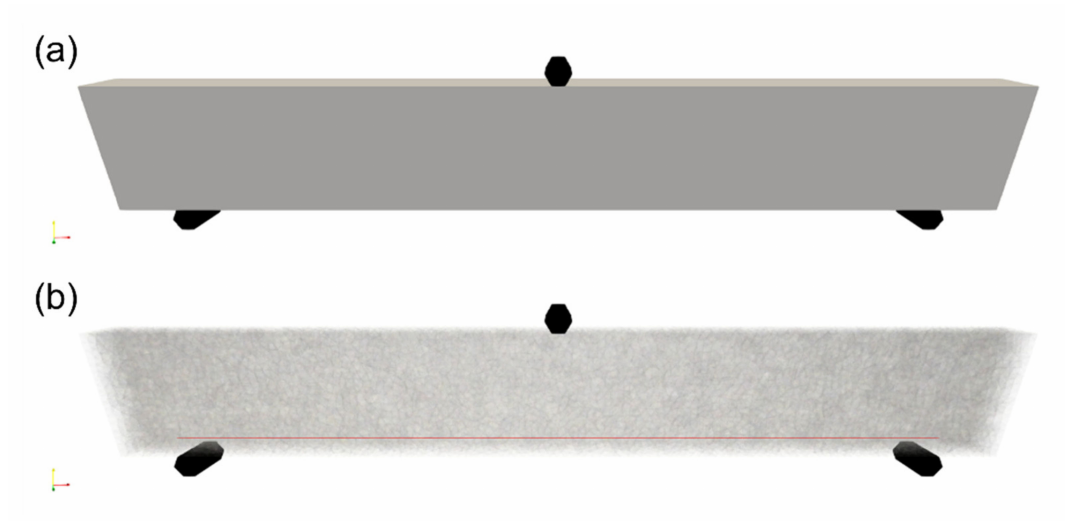
Figure 7. Numerical simulation model for the three-point bending test of the RC beam: ( a ) the specimen geometry and ( b ) the rebar inserted in the